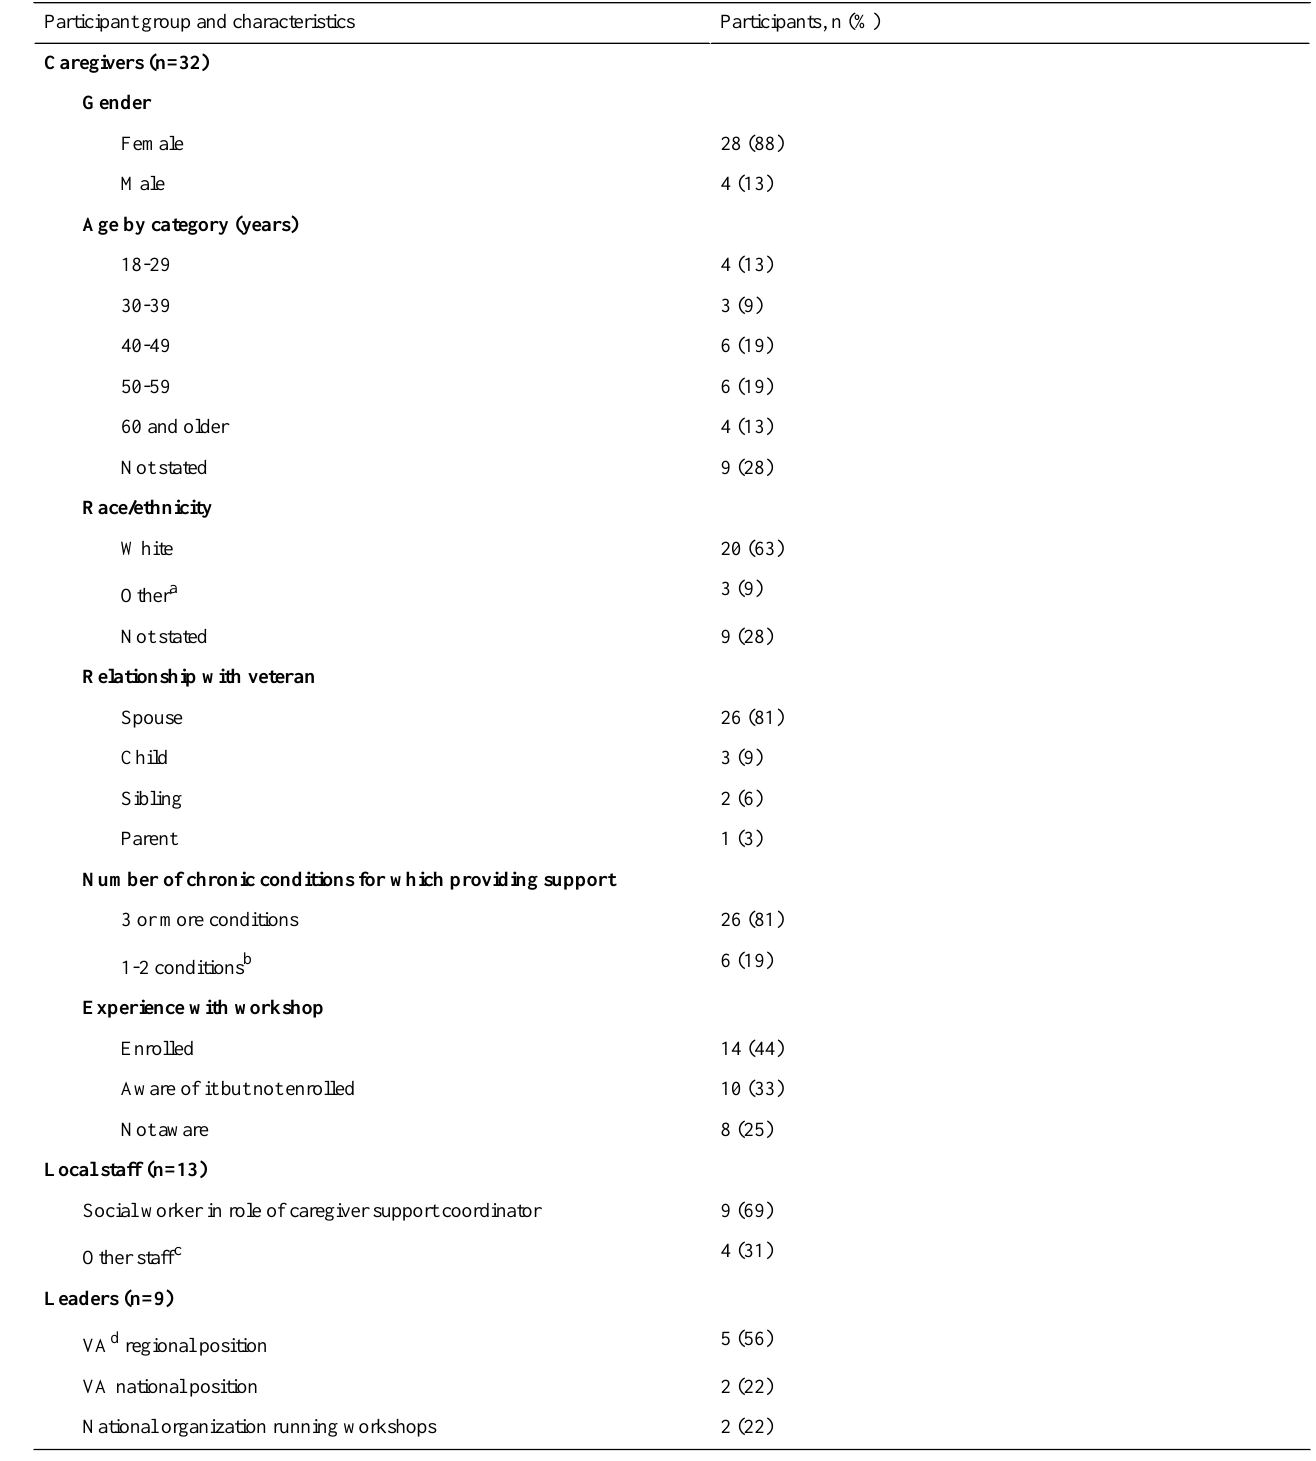
Table 2. Characteristics of caregivers, local staff, and regional and national